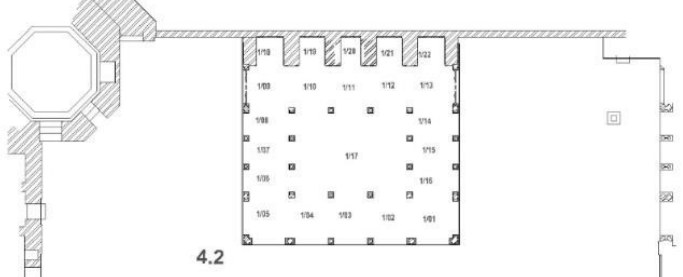
Figure 5. Planof Diwaan e Khaas